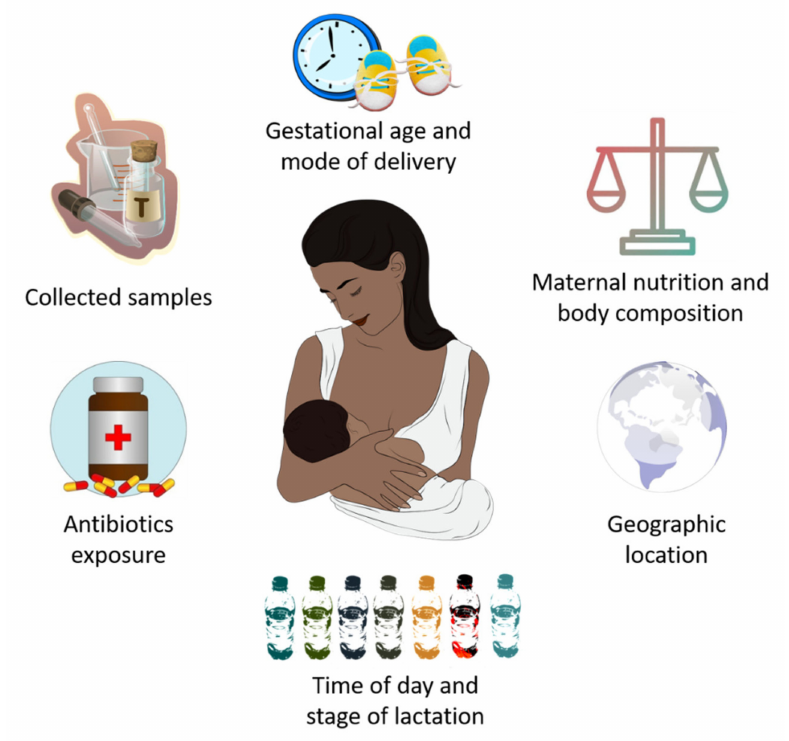
Figure 1. Potential factors that influence breast milk microbiota